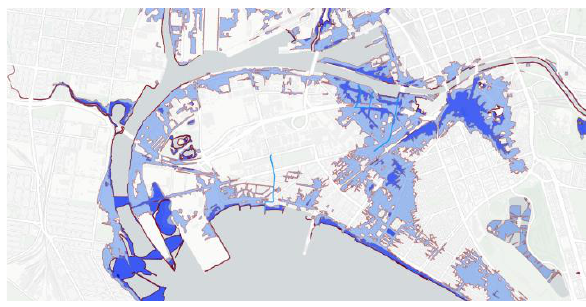
Figure 2: 2D visualisation of 2100 flood impact modelled scenario